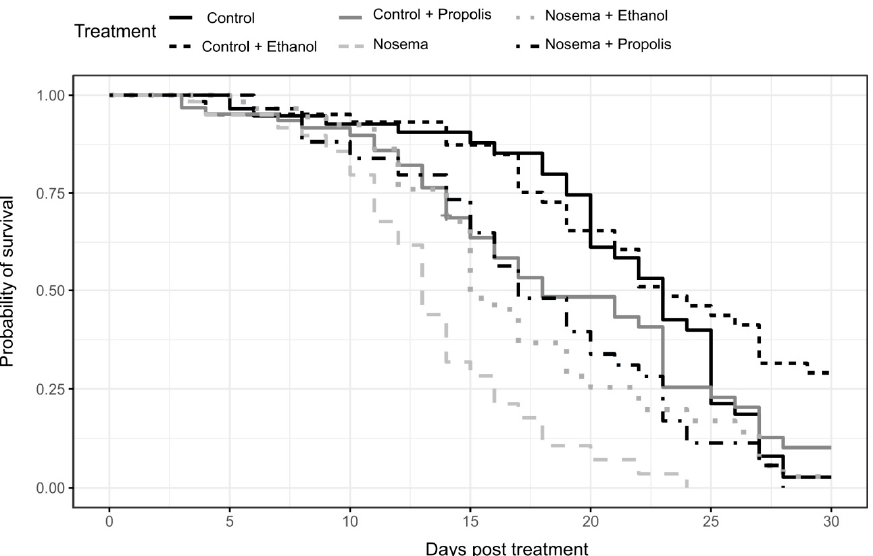
Figure 1. Survival of caged and experimentally treated honey bees ( Apis mellifera ): Control, Control + Ethanol, Control + Propolis, Nosema, Nosema + Ethanol and Nosema + Propolis.